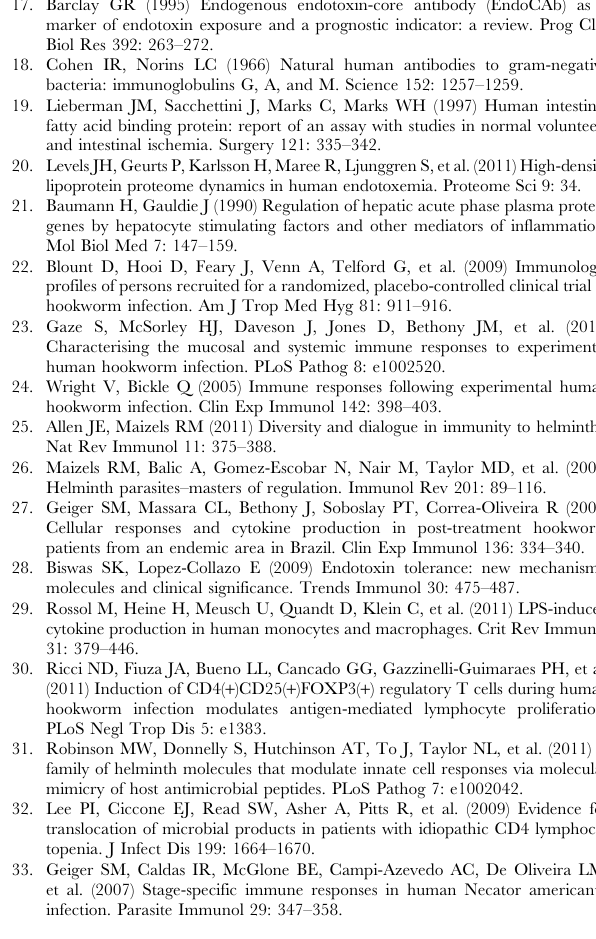
Figure S1 Gating strategy for estimating frequencies of naı¨ve, central and effector memory T cells and nTregs. A representative flow cytometry plot showing the gating strategy